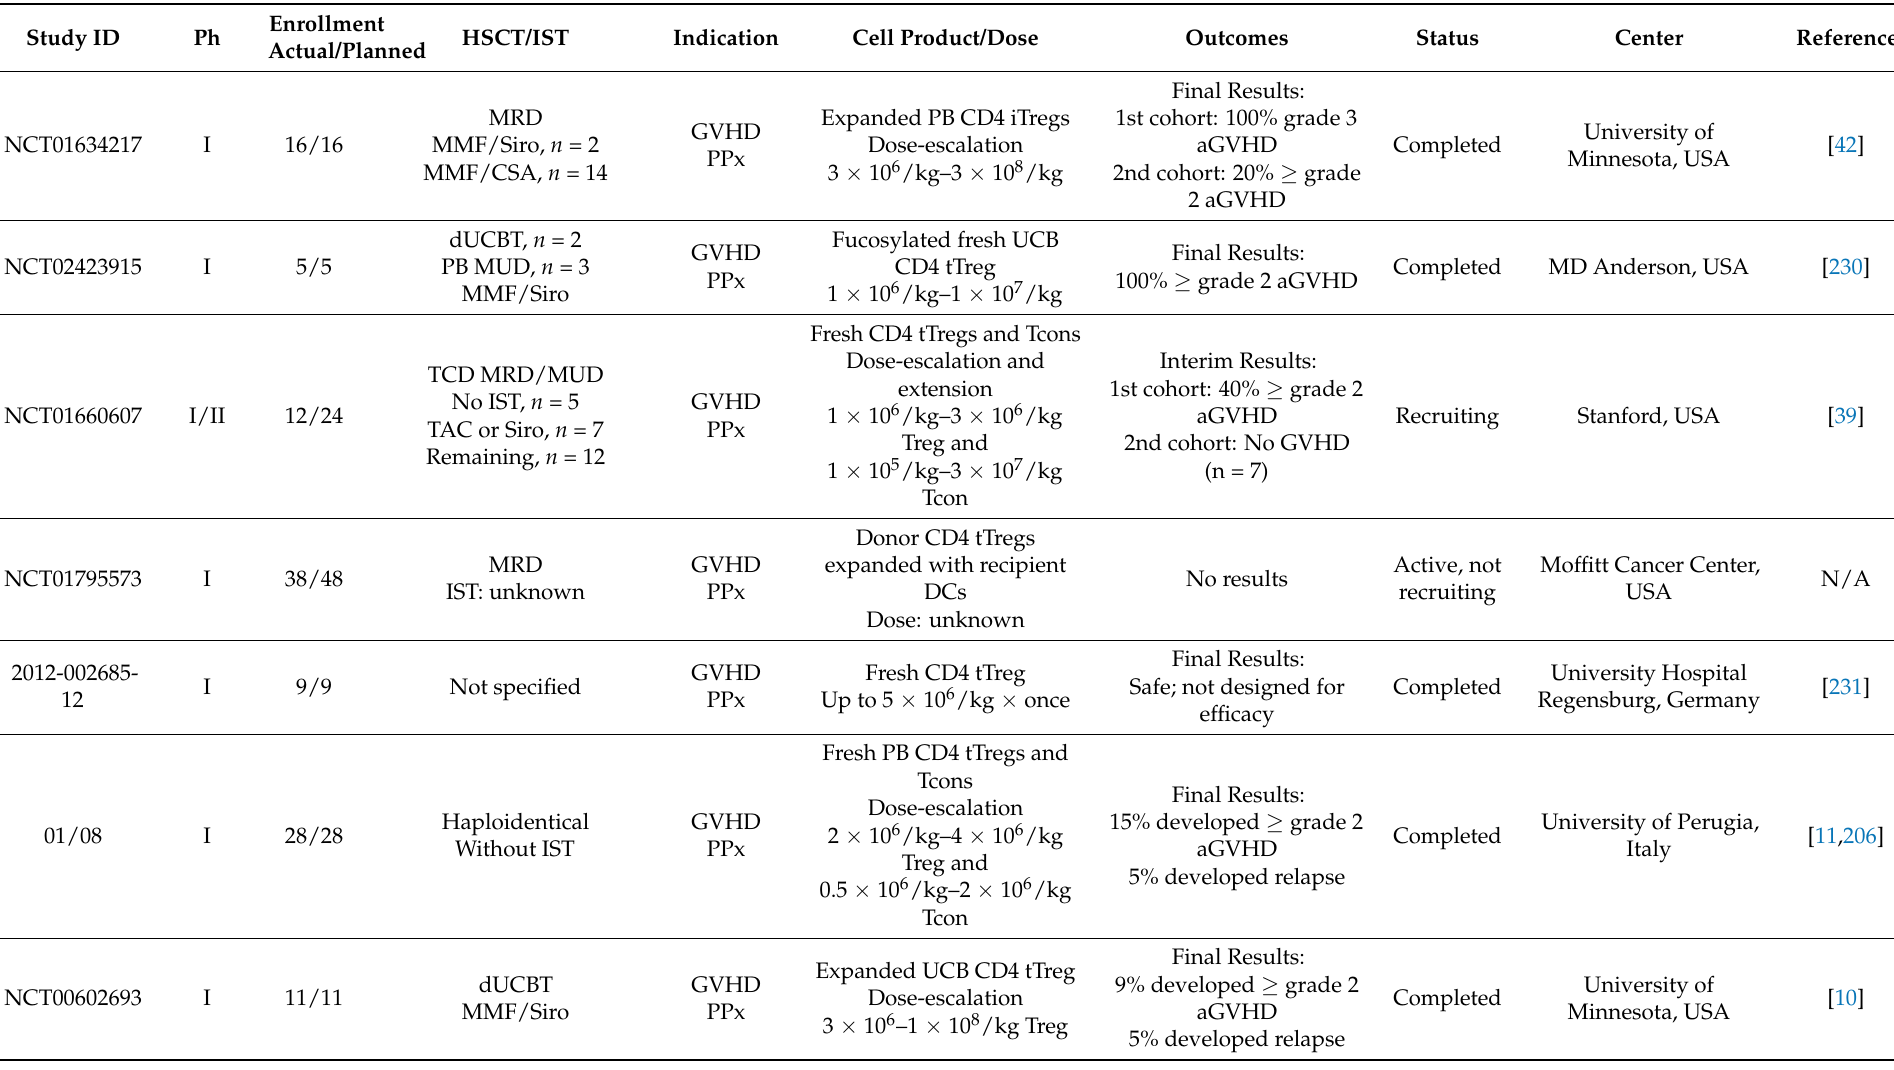
Table 2. Completed and ongoing clinical trials involving adoptive Treg therapy in GVHD (ClinicalTrials.gov; search date 30 July